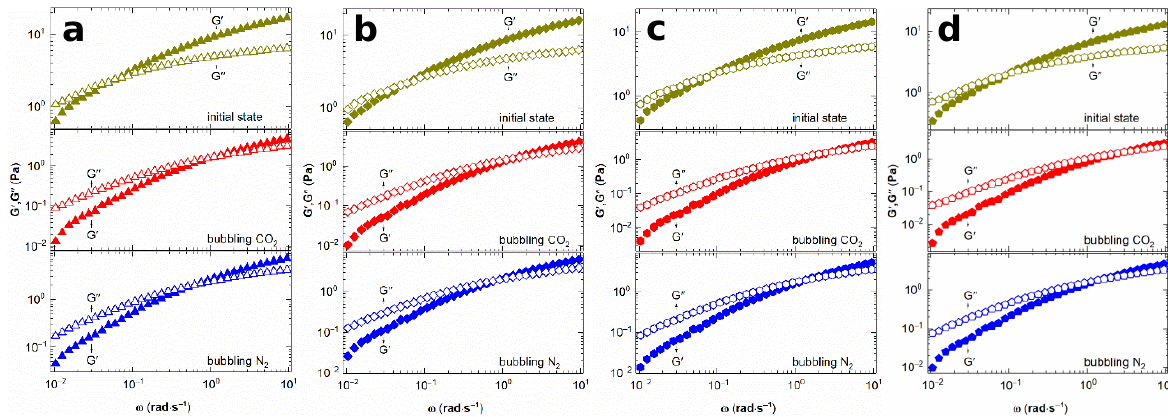
Figure 4. Frequency sweep curves of 0.65 wt% NaPAA aqueous solutions containing ( a ) 0.60 wt%, ( b ) 1.20 wt%, ( c ) 2.40 wt%, and ( d ) 4.80 wt% DMEA before and after treatment of CO 2 and N 2 , measured at shear strain of 10 % at 25 °C.